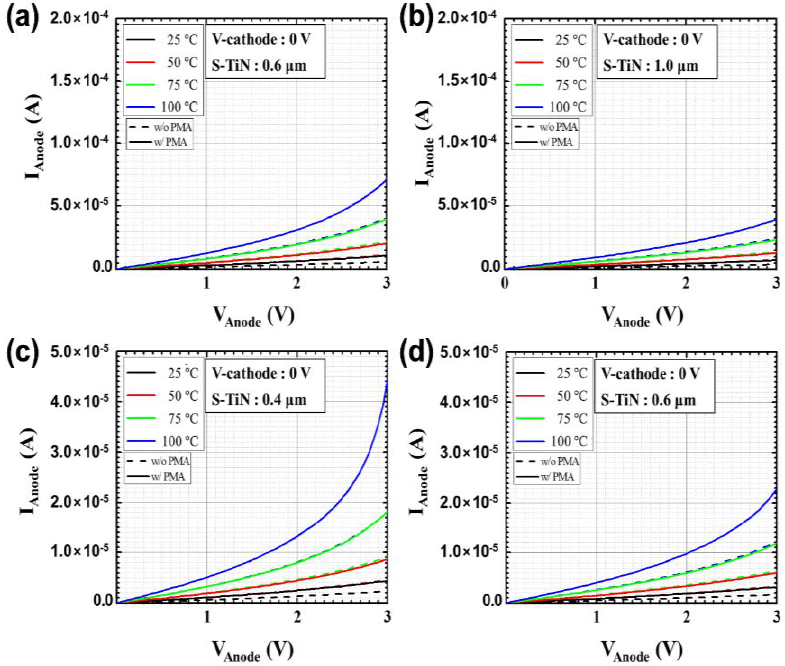
Figure 9. Measured DC characteristics according to the temperature (25, 50, 75, and 100 °C) of the four types of a-Si microbolometers before (dotted lines) and after (solid lines) applying the PMA process: ( a ) P35-S06, ( b ) P35-S10, ( c ) P12-S04, and ( d ) P12-S06. Here S-TiN stands for the pattern spacing of TiN layer.